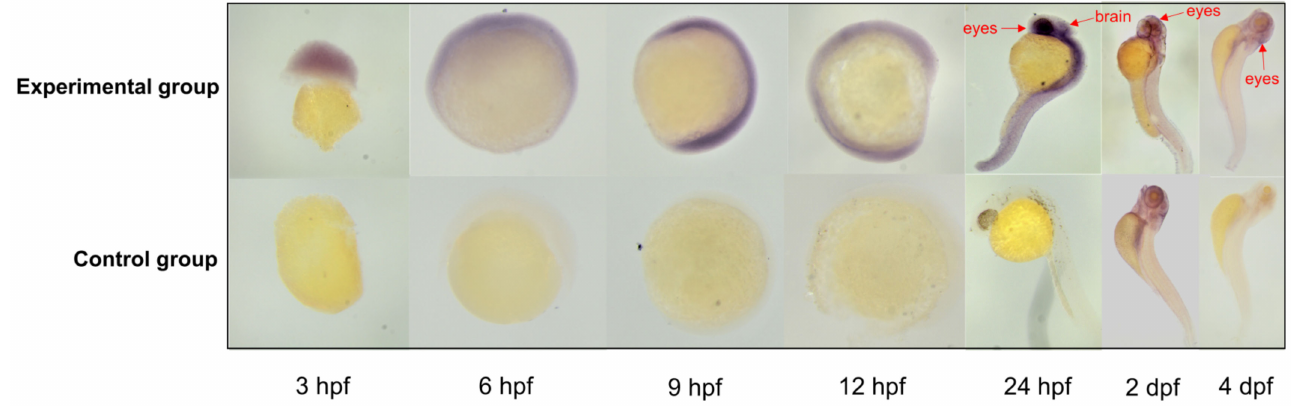
Figure 6. In situ hybridization for itgav transcripts at different stages of wide type zebrafish embryos. Red arrows indicate similar expression patterns to GFP in the EYE line. Experimental group: zebrafish embryos treated with itgav antisense RNA probes. Control group: zebrafish embryos without probe